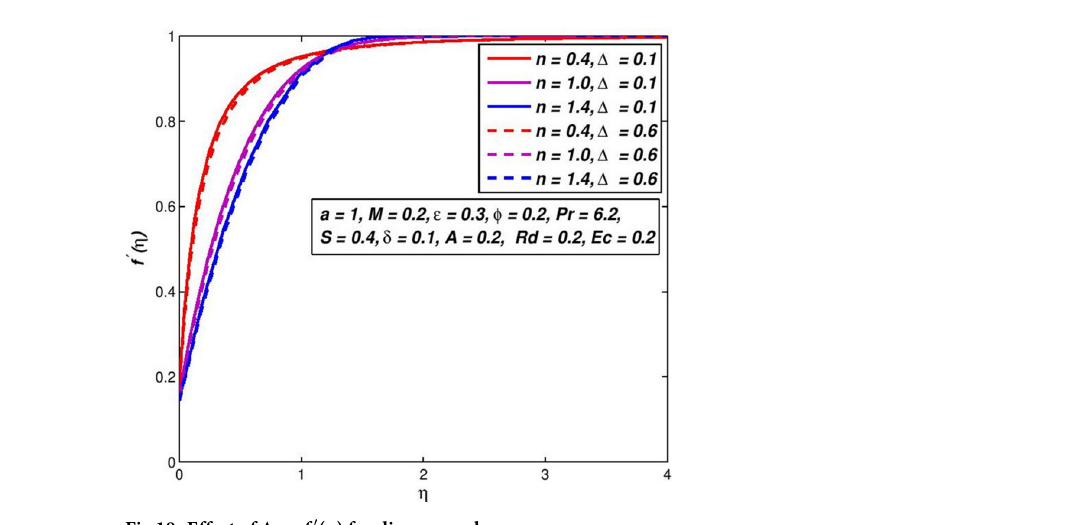
Fig 18. Effect of Δ on f 0 ( η ) for diverse n values.